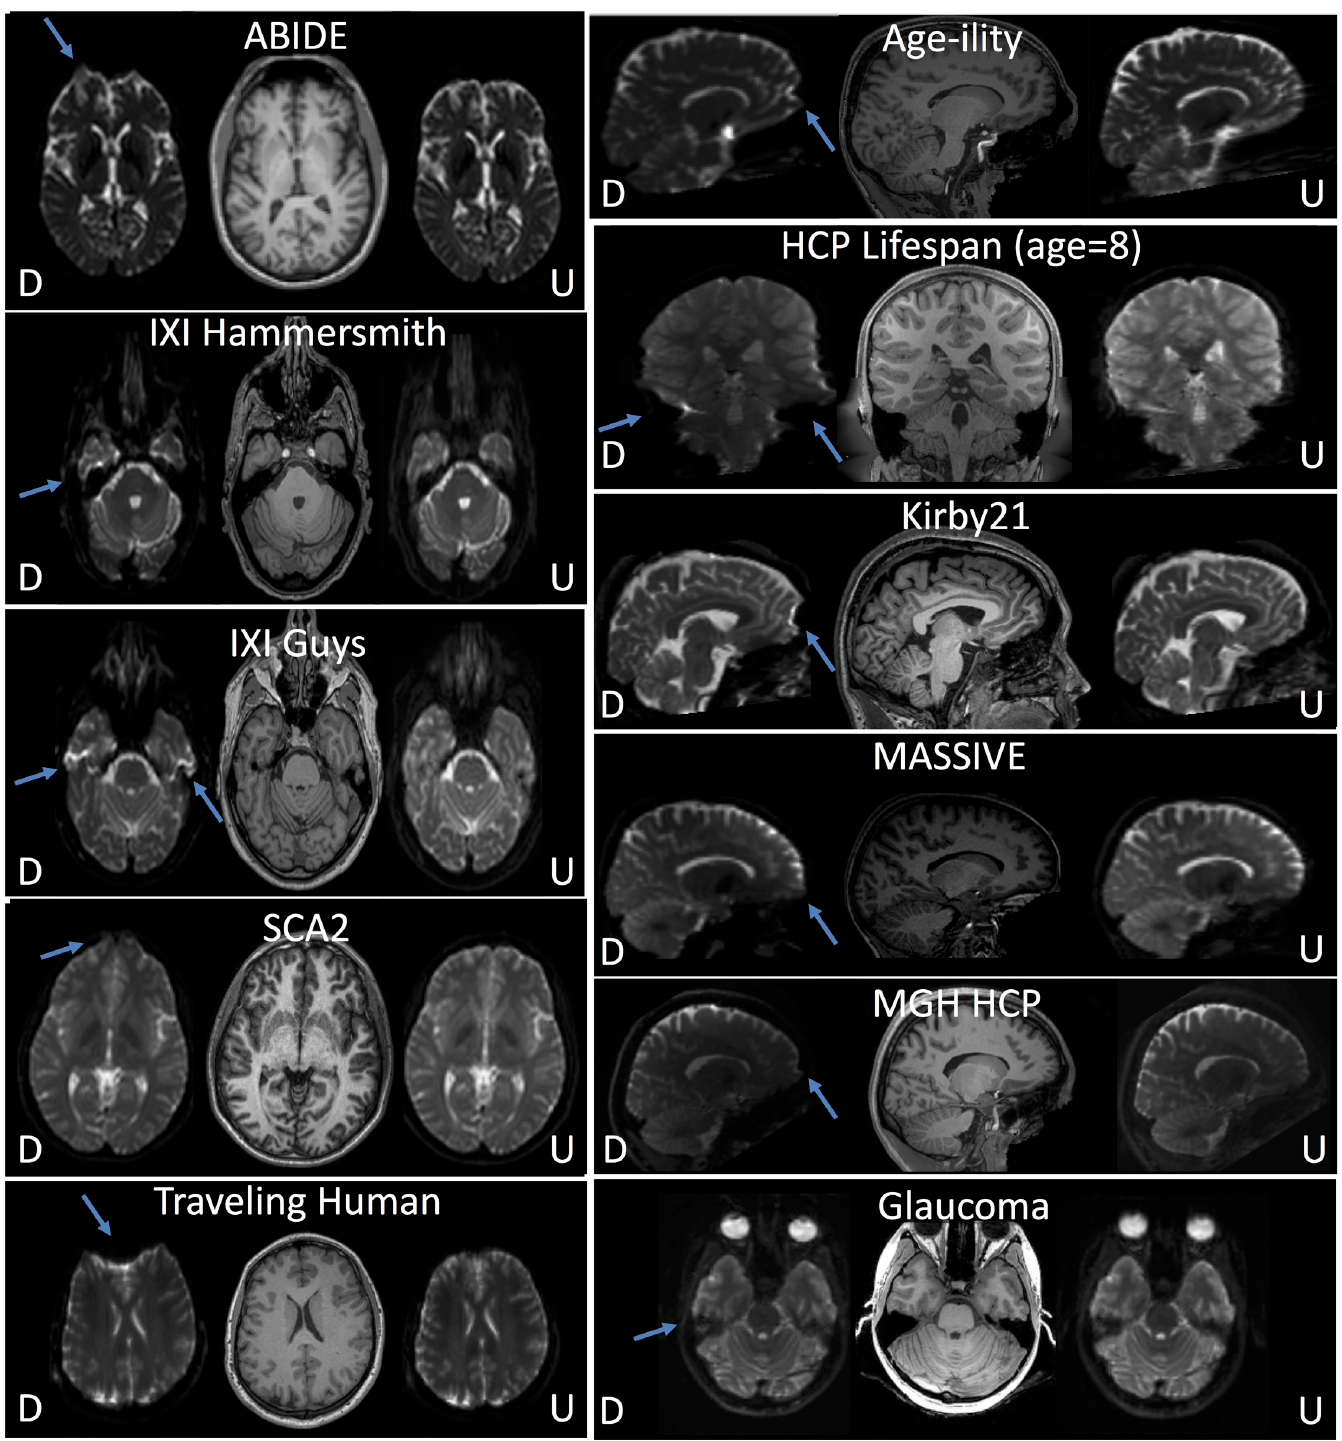
Fig 8. External dataset validation. External validation of corrected b0’s after applying the synthesized b0 distortion correction pipeline with data from open-sourced studies. The distorted (“D”) and undistorted (“U”) b0 images are shown alongside T1 images. In all cases, effective distortion correction is visually apparent (distortions indicated by